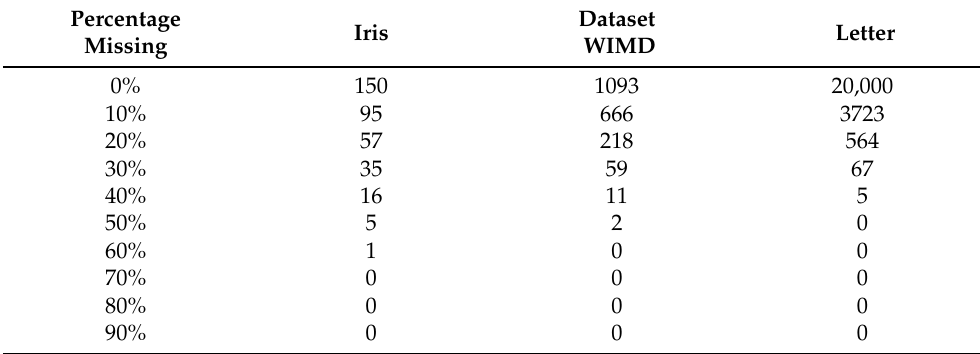
Table 2. Number of complete observations remaining in each dataset after different proportions of data were removed at